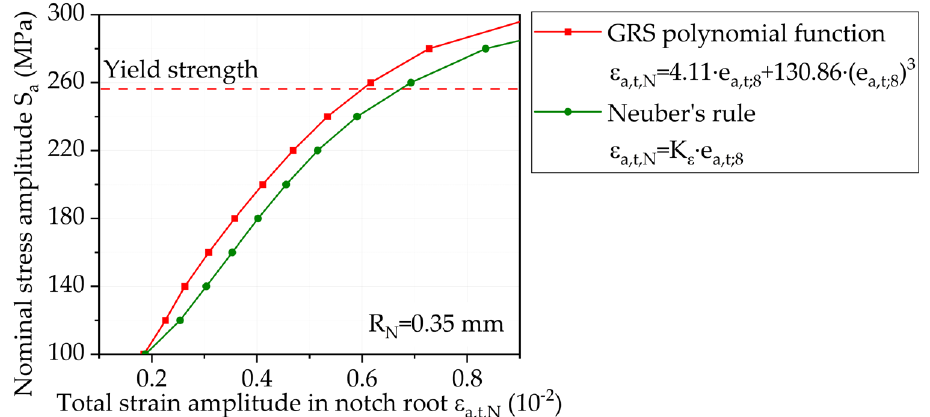
Figure 14. Comparison of calculated values using polynomial function derived from FEM simulation and analytical approaches for specimens with R N = 0.35 mm.